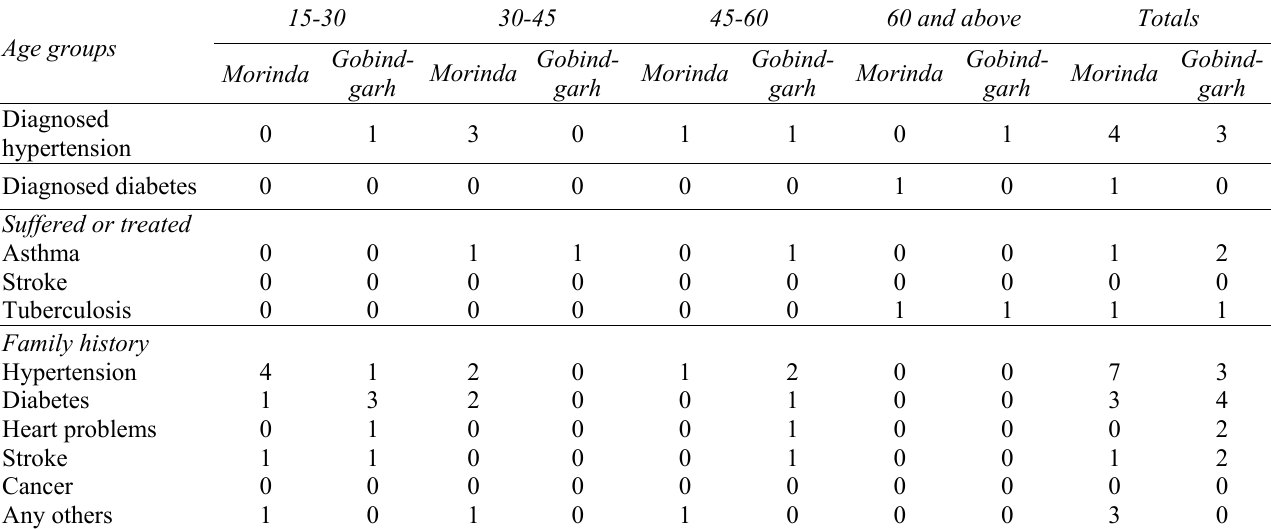
Table 6b : Prevalence of different susceptibility factors in female population of different age groups in the two study sites. Age groups